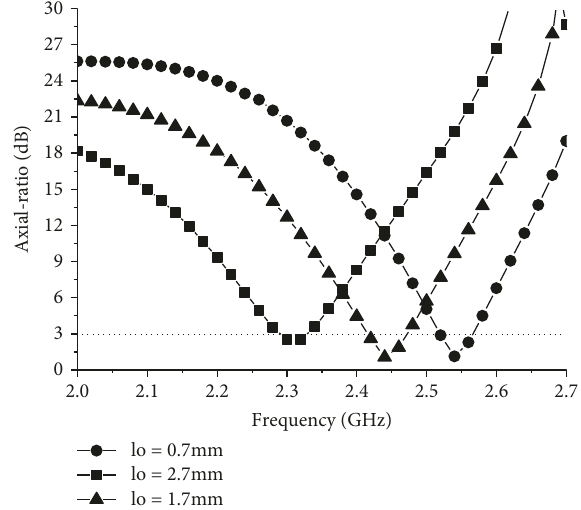
Figure 6: Simulated axial ratio with di ff erent values of